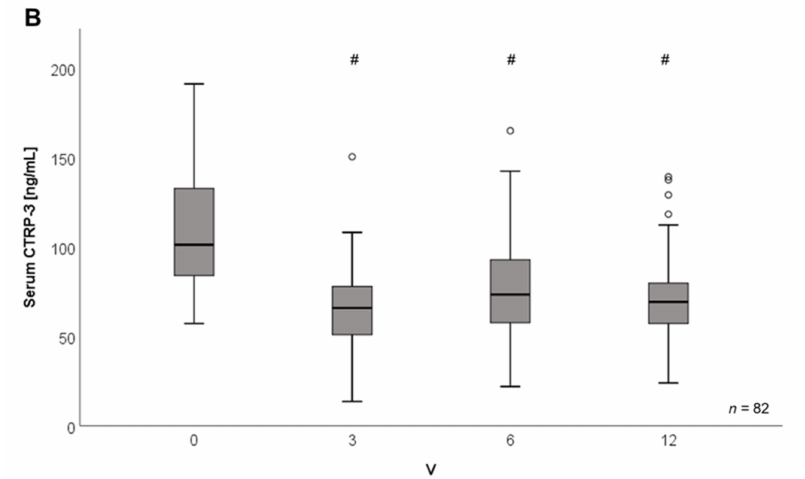
Figure 3. CTRP-3 serum concentrations decrease during weight loss induced by bariatric surgery or low-calorie diet, respectively. CTRP-3 serum concentrations were measured by ELISA. BS, bariatric surgery; LCD, low calorie formula diet; study points: V0, start of intervention; V1, 3 days post-surgery; V3, V6, V12 = 3, 6, 12 months after start of intervention. ( A ) Rapid and sustained decline of circulating CTRP-3 levels upon bariatric surgery. Outliers; * extreme values; # p < 0.001 when compared to V0; p = 0.024 between V1 and V3. ( B ) Sustained decline of circulating CTRP-3 levels during LCD. *, outliers; # p < 0.001 when compared to